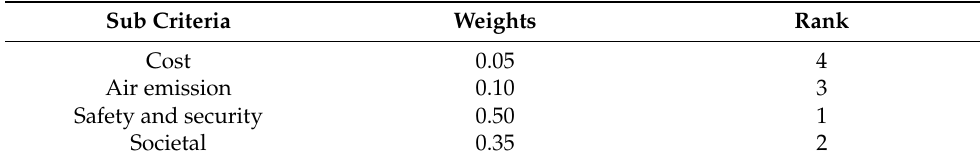
Table 3. The sub-criteria